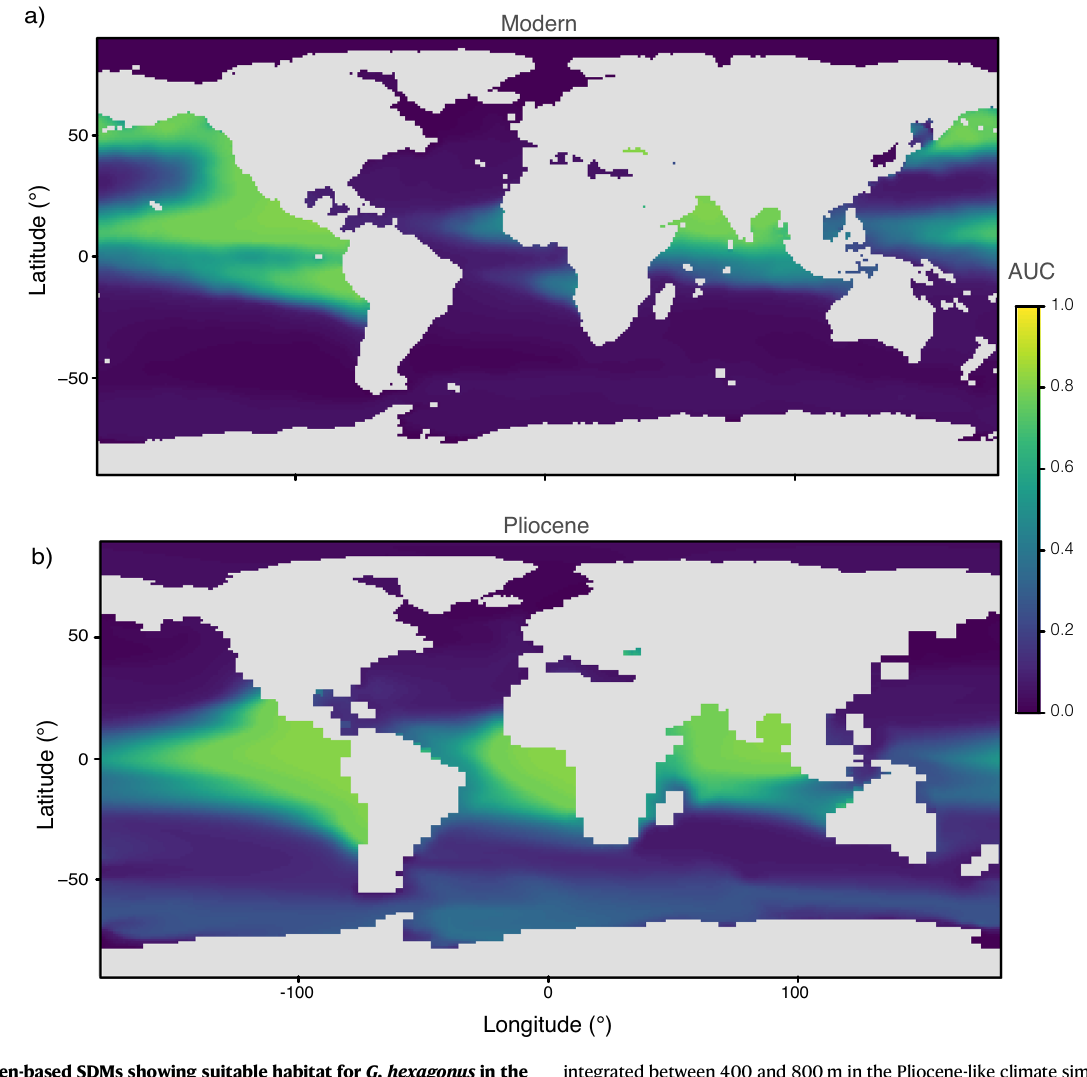
integrated between 400 and 800m in the Pliocene-like climate simulation. AUC (true positive rate versus false positive rate) ranges between 0 and 1, with 1 indi- cating perfect prediction by the